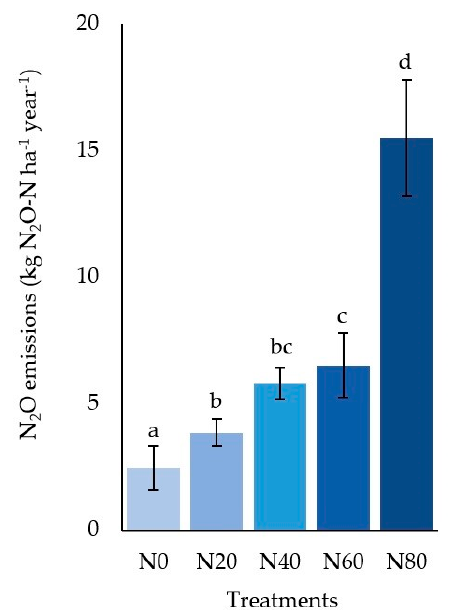
Figure 3. Accumulated N 2 O-N emissions for the di ff erent N fertilization treatments (N0, N20, N40, N60, and N80) over the trial period. Error bars denote standard error of the mean. Di ff erent letters indicate significant di ff erences between the treatments ( p < 0.05). The N0, N20, N40, N60, and N80 refer to the fertilizer rates used as treatments and were 0, 220, 440, 660, and 880 kg N ha − 1 year − 1 , respectively.